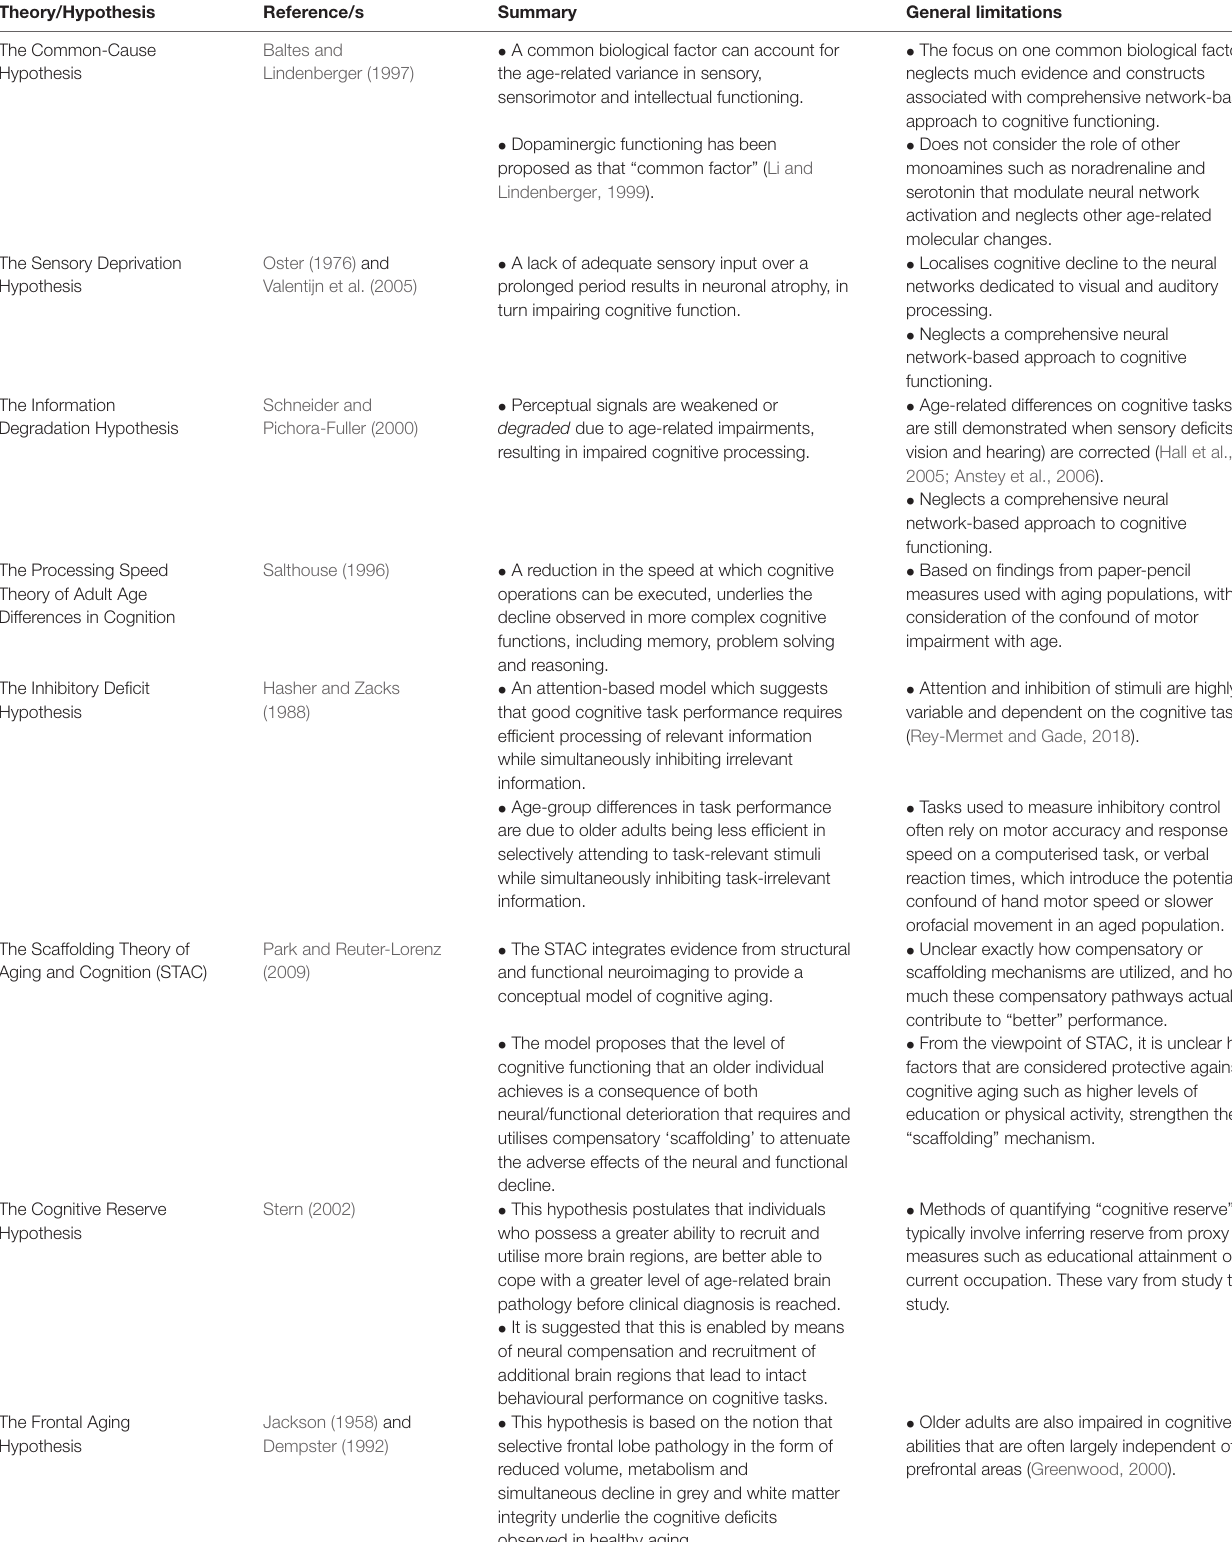
TABLE 1 | Summary of theories pertaining to age-related cognitive decline.